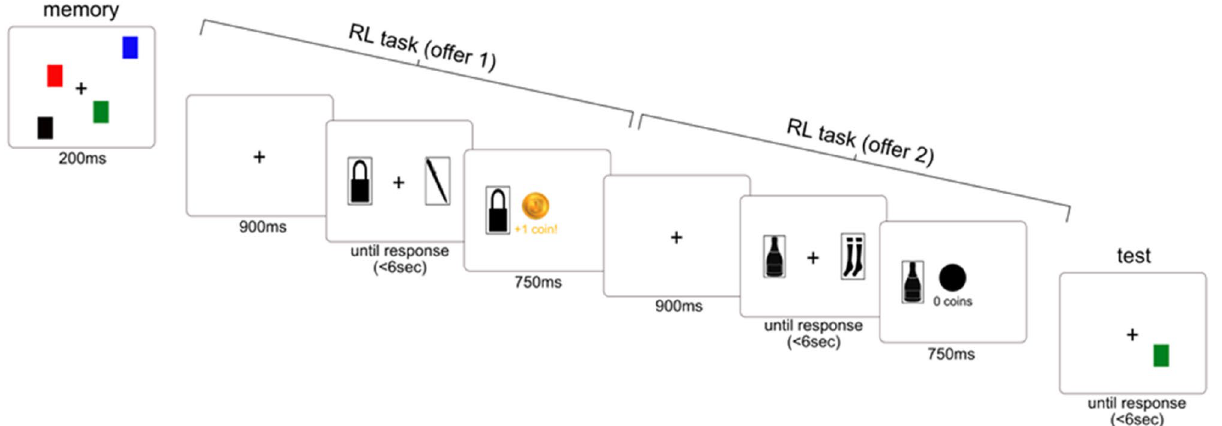
Figure 1. Trial sequence in the reinforcement learning task, which was performed under varying working memory loads. Participants were asked to first memorize a visual array (memory array stage), then make two choices across two card offers (reinforcement learning bandit task stage), and finally report whether a target was the same or different compared to the visual array that was memorized at the trial initiation (test array stage). Working memory load was manipulated between blocks by including in the memory stage either four random colored squares (high load), one random colored square (low load), or a fixed color square throughout the entire block, thus not requiring subjects to maintain the color in working memory during the task